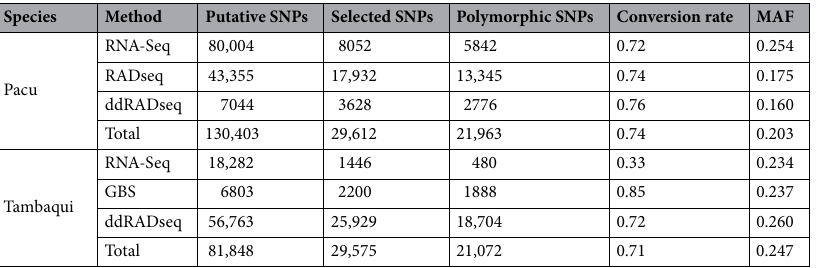
Table 2. SNP performance in the Axiom array, according to the method of SNP discovery in each